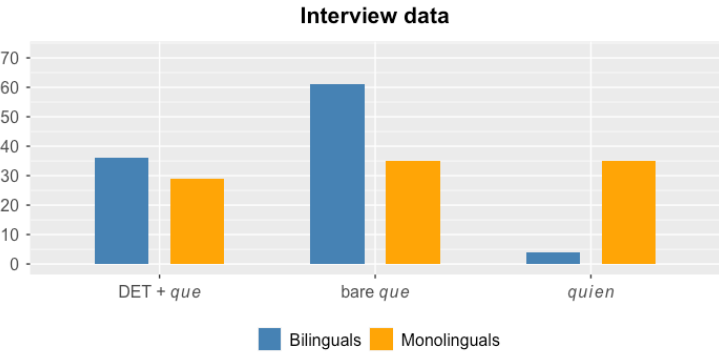
Figure 3. Results for the interview cleft data (as a percentage).